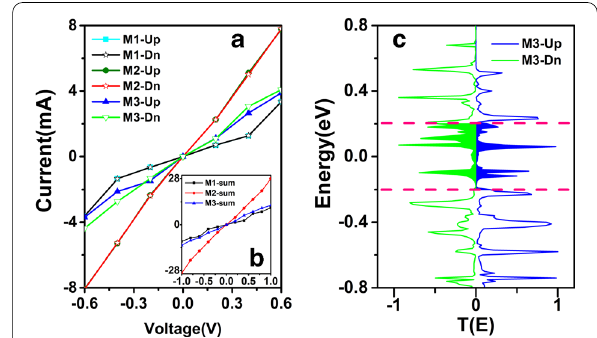
Fig. 6 (Color online) a The calculated spin-dependent I–V curves as a function of the applied bias for M1, M2 and M3. The insert (a ′ ) shows the calculated total currents for each device. b The spin-dependent transmission spectra for M3 at bias 0.04 V. The shaded area between − the pink dotted lines is the energy region contributing to the current, i.e. the bias window (The shaded blue and green area on the right and left sides donate the spin up and spin down,